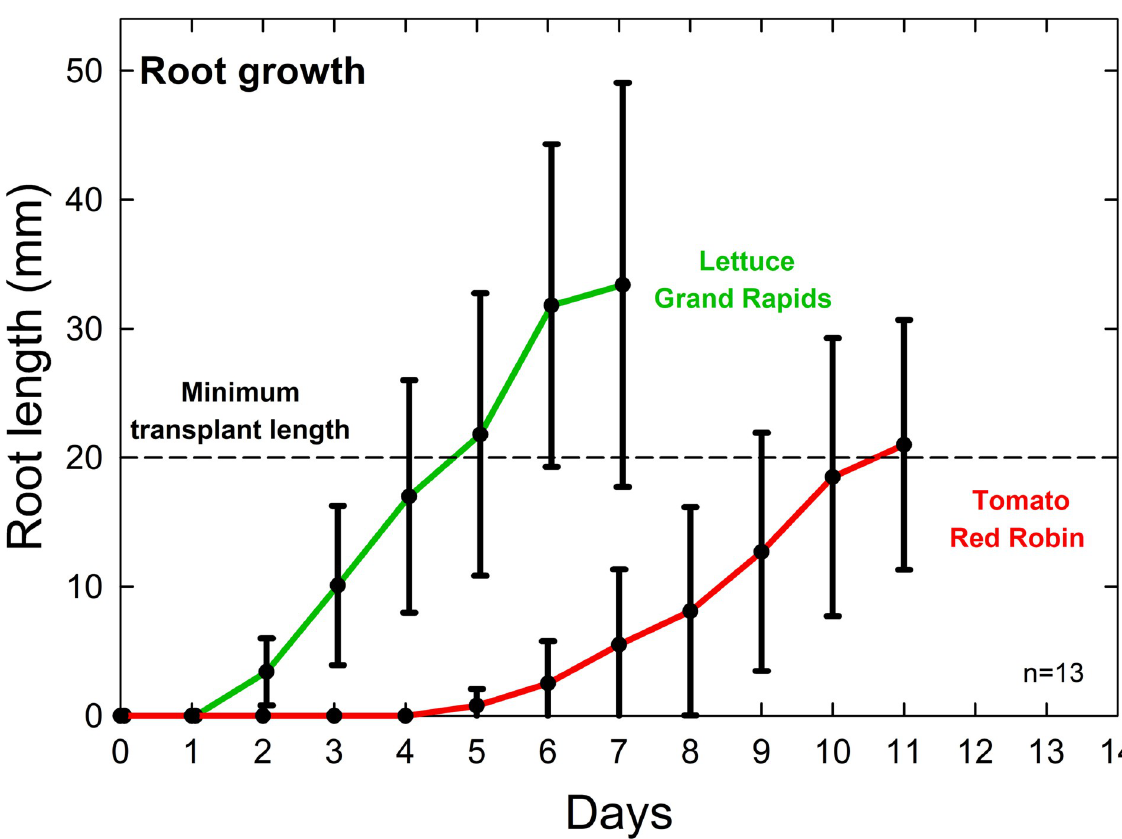
Fig 11. Example of rapid and excessive growth of lettuce (cv. Grand Rapids) and tomato (cv. Red Robin) roots over time. Root elongation rate starts to decrease after roots are 20 to 30 mm long. Error bars represent standard deviation, n = 13. There is a large variability among seedlings. Overplanting by a factor of at least two allows for selection of the most vigorous seedlings.